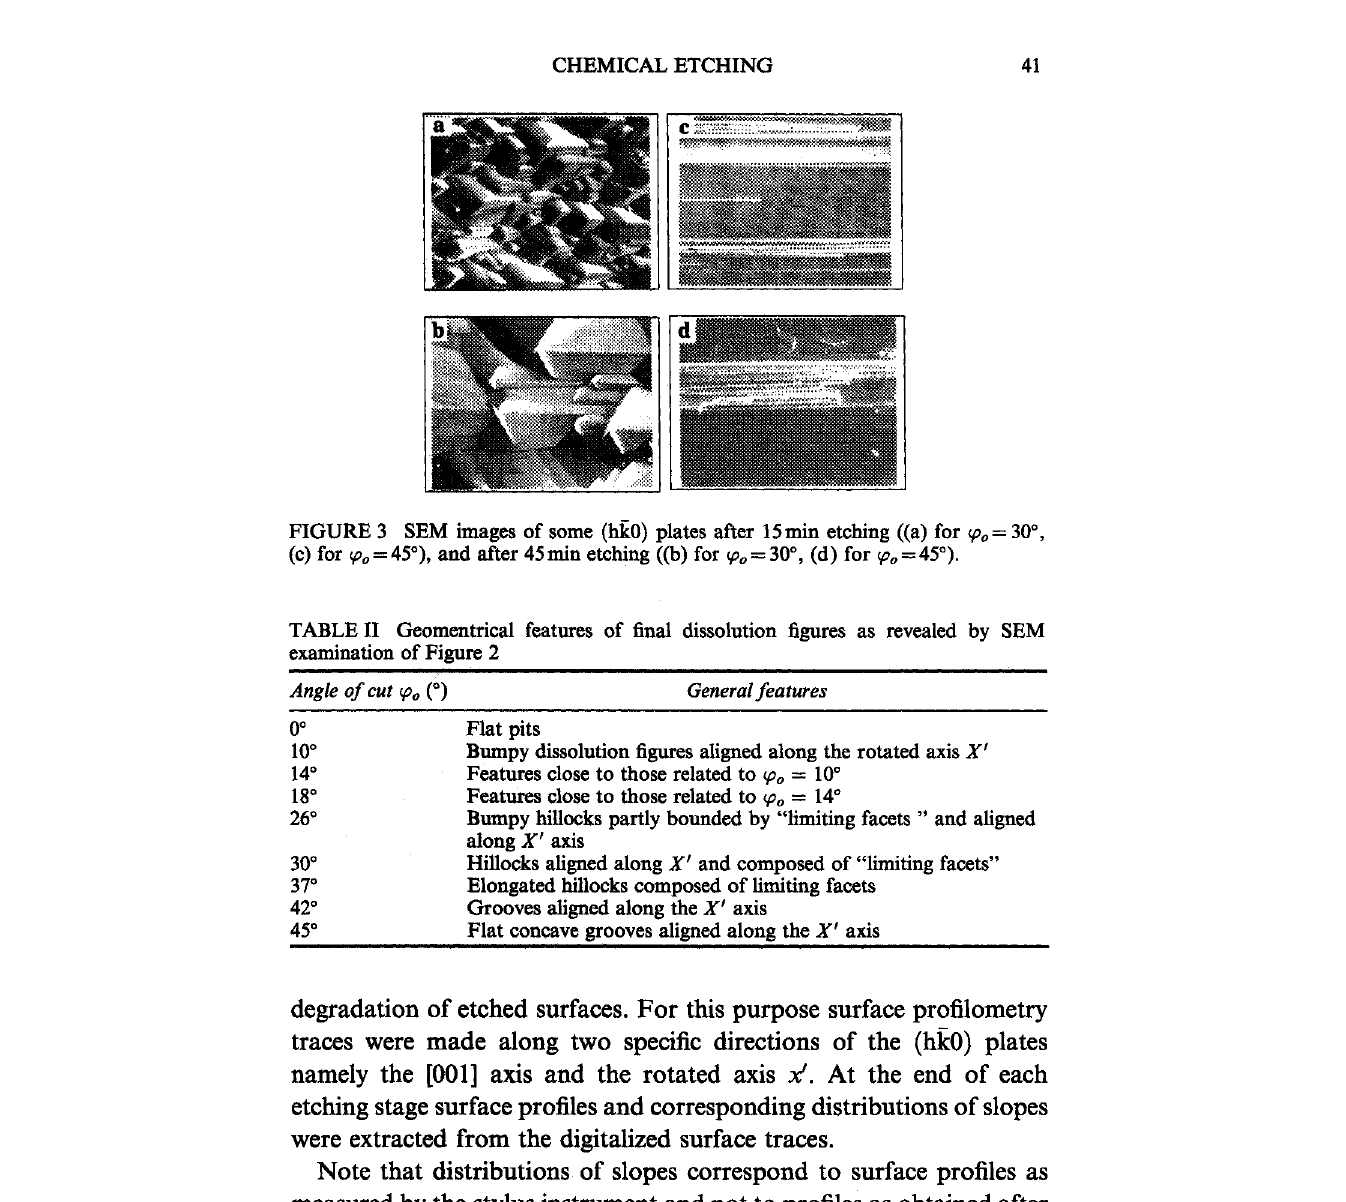
TABLE II Geomentrical features of final dissolution figures as revealed by SEM examination of Figure 2 Angle of cut +90 (0) General